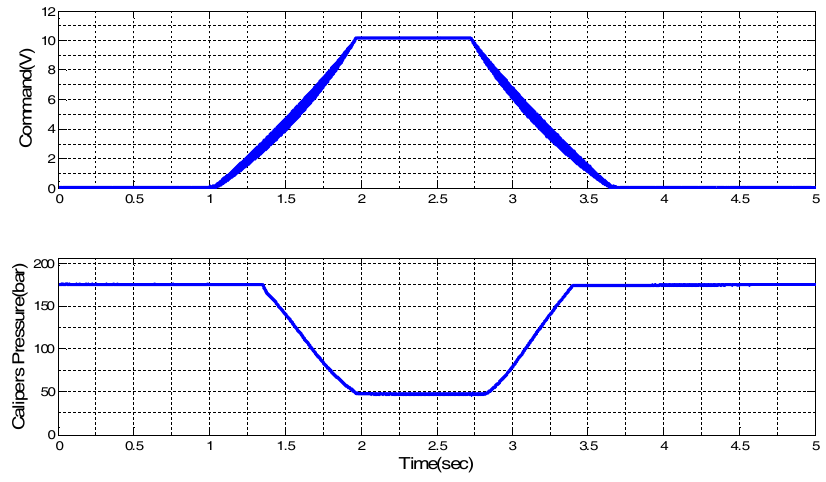
Figure 20. Triangular wave command at proportional valve relief test in 175 bars.